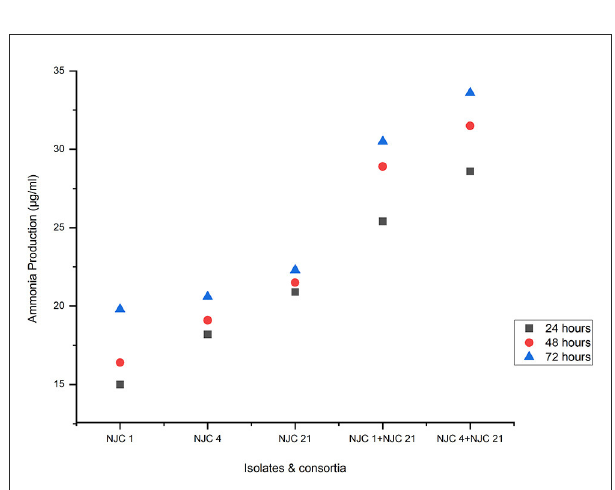
treatment with PC2 and dry biomass linked to single culture